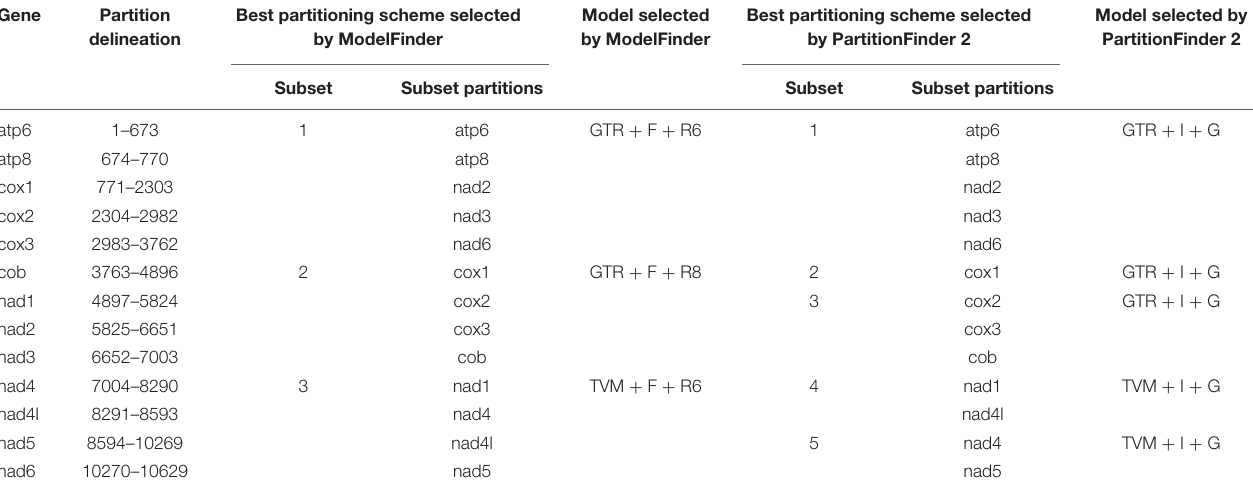
TABLE 4 | Alignment information and selected DNA substitution model in this study. Gene Partition Best partitioning scheme selected delineation by ModelFinder